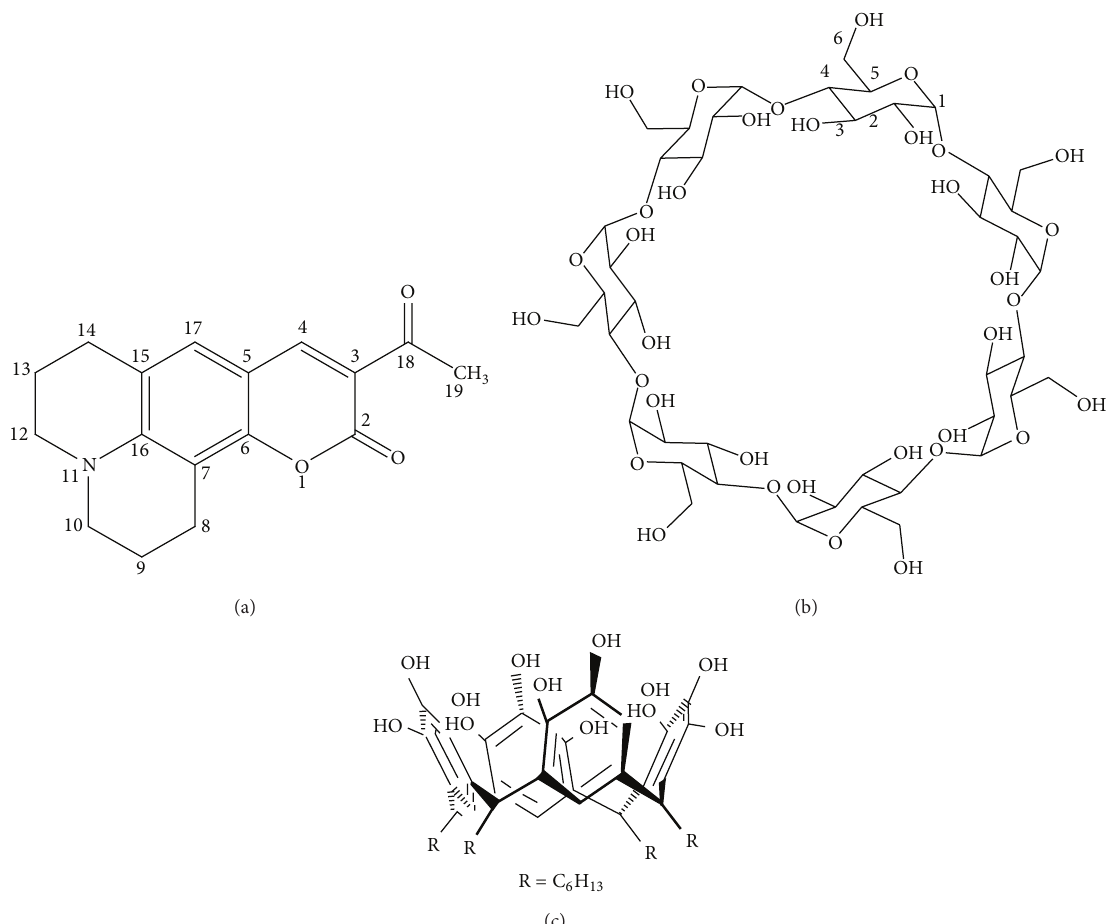
Figure 1: (a) Structure of C334. (b) Structure of 𝛽 -CD. (c) Structure of